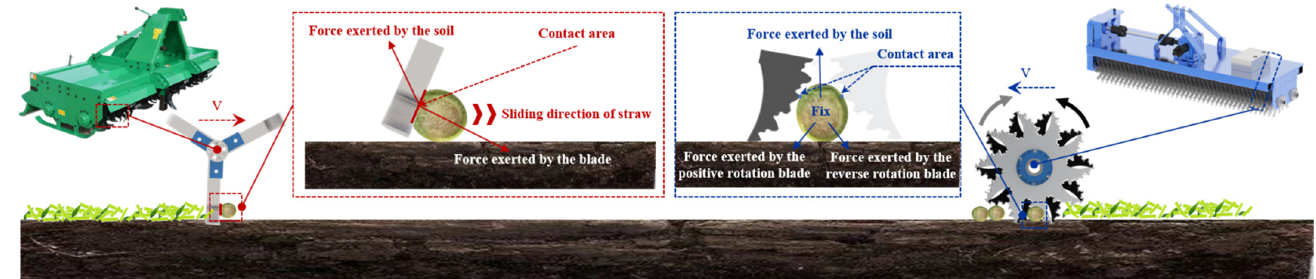
Figure 6. Comparison of the operating principle between traditional straw returning machine and bionic straw returning machine. The straw slips during the operation of traditional straw returning machine, and the contact area between the blade and the straw is large. During the operation of the bionic straw returning machine, the straw is fixed and the contact area between the blade and the straw is smaller.